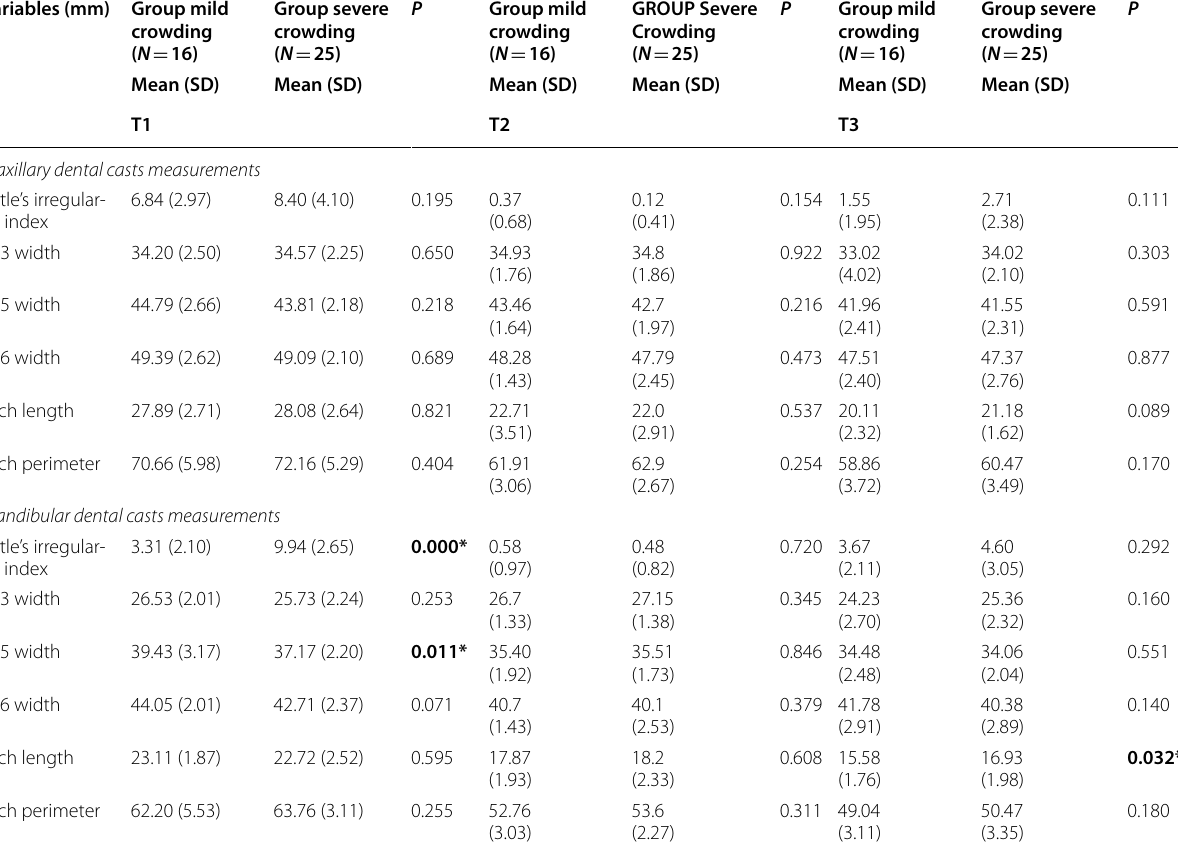
Table 2 Results of intergroup comparability at pretreatment (T1) posttreatment (T2) and postretention (T3) (independent t